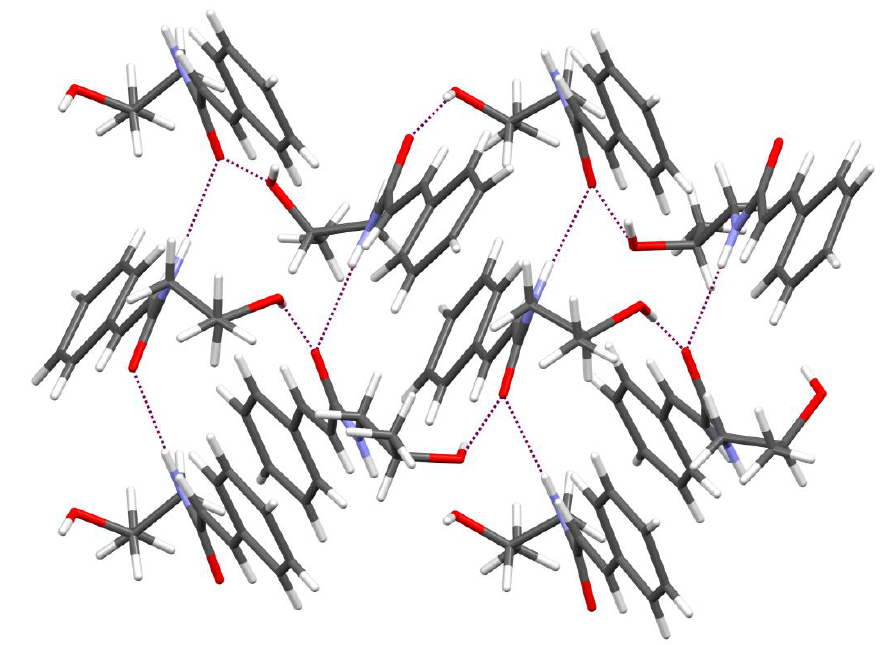
Figure 6. Partial packing view of KM-568 molecules projected along [010] direction. Dashed lines indicate hydrogen bonds.